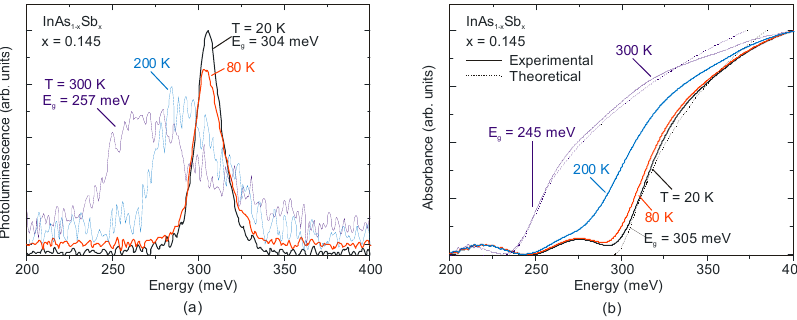
Figure 12. PL ( a ) and absorbance ( b ) spectra of 5- μ m thick InAs 0.855 Sb 0.145 MBE epilayer deposited on GaAs substrate with 3- μ m thick InAs buffer layer. The residual background donor concentration is 3 × 10 16 cm − 3 (after [47]).